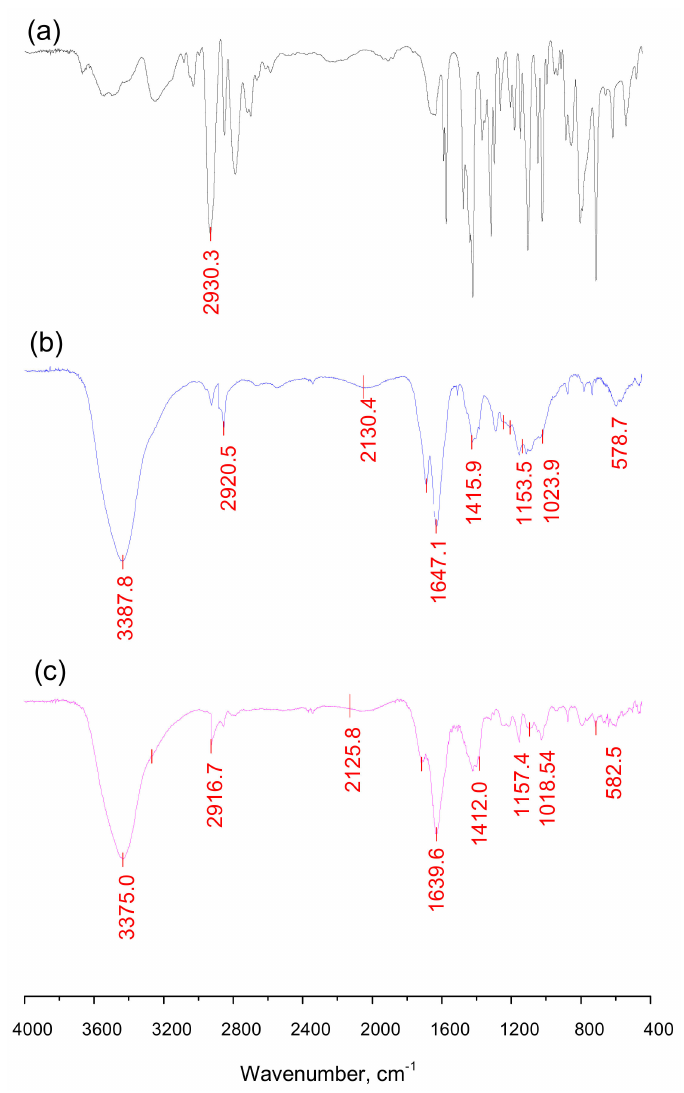
Figure 14. FTIR spectra of anabasine ( a ), β -CD ( b ), and its inclusion complex ( c )